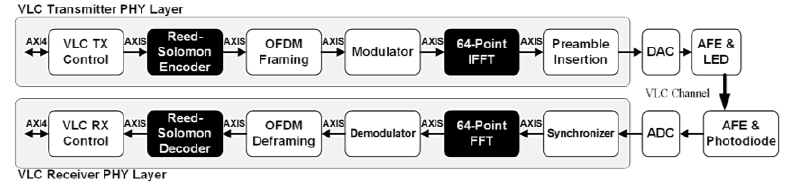
Fig. 2. VLC PHY block diagram